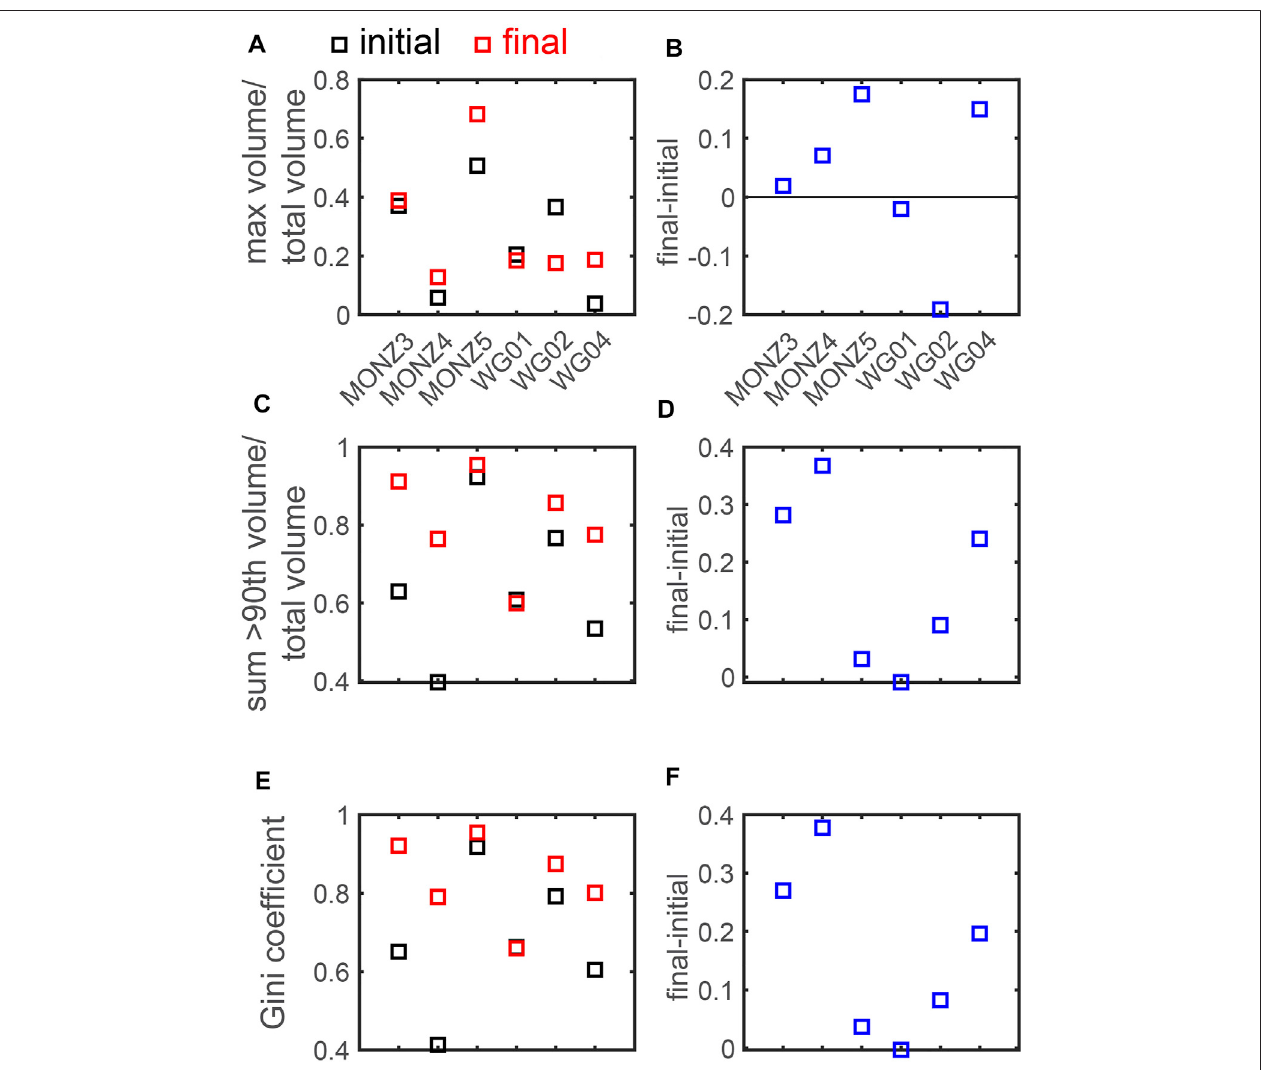
FIGURE6| Differenceinthev max /v tot (A,B) , (cid:1) v 90 / v tot (C,D) ,andtheGinicoef fi cient (E,F) fromtheinitialand fi naltomogramacquiredineachexperiment.Positive changes from the initial to fi nal scan indicate increasing localization. The results of the Gini coef fi cient and (cid:1) v 90 / v tot are nearly identical.